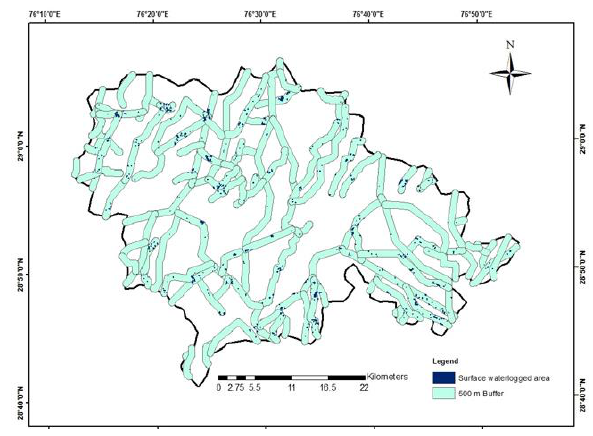
Fig 14: Surface waterlogged areas within the canal buffer (Post-monsoon) Table 15: Results of surface waterlogged areas within canal buffer (Post-monsoon)